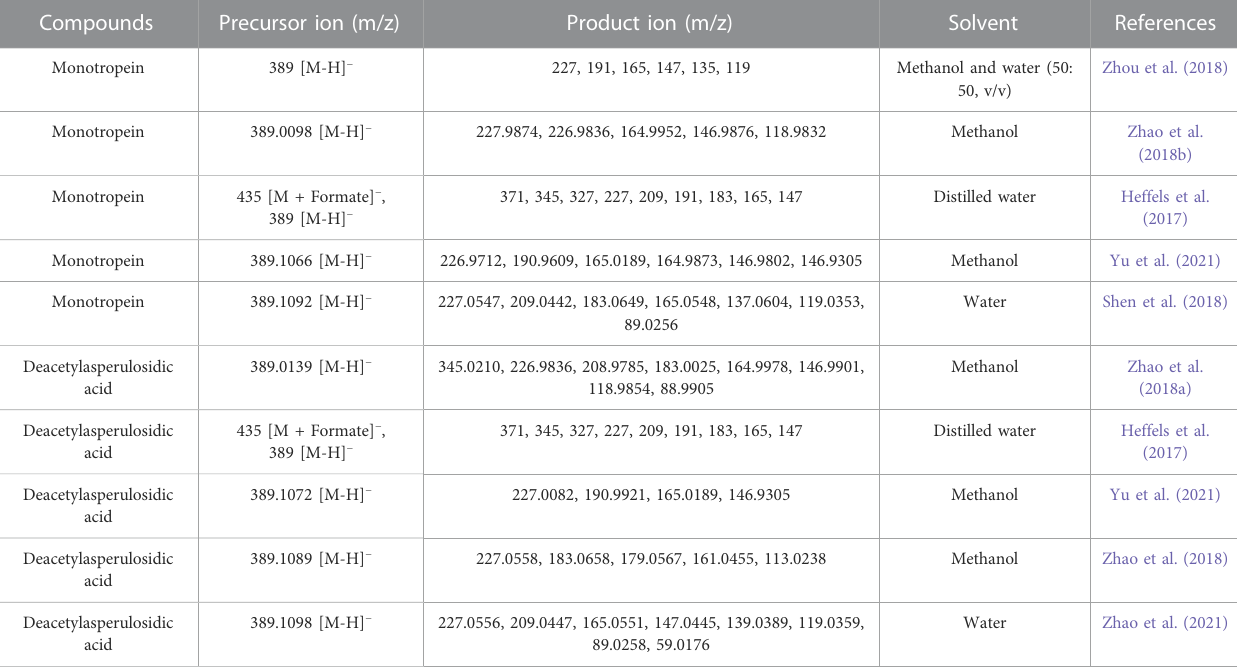
TABLE 1 The fragmental ions of monotropein and deacetylasperulosidic acid in negative ionization mode.